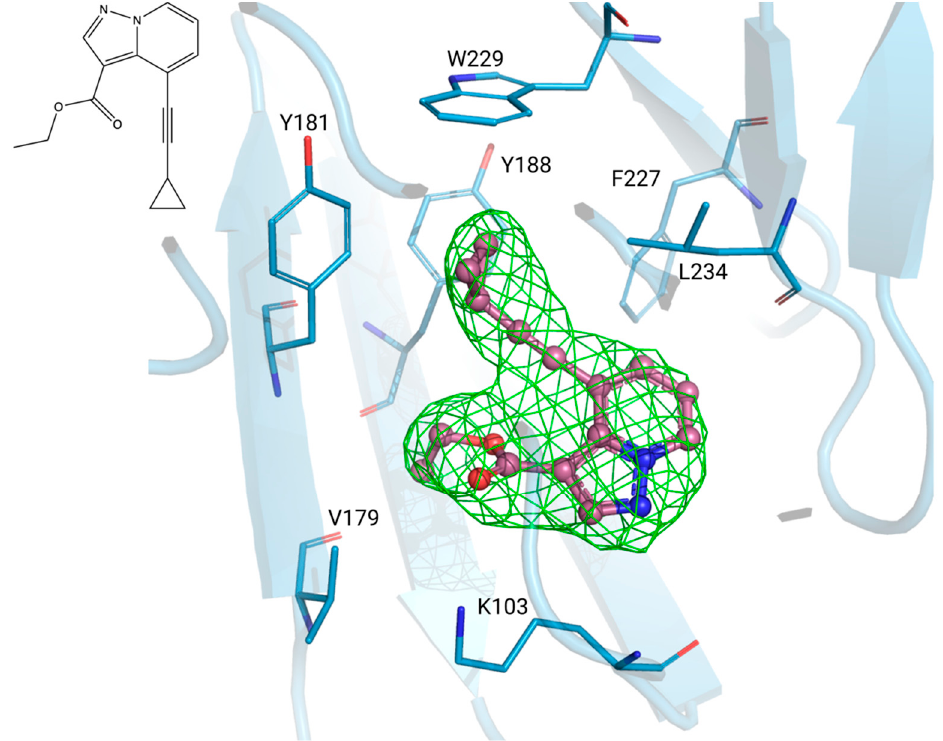
Figure 3. Crystal structure of HIV-1 RT in complex with the elaborated compound 27 (PDB ID 8FFX). Atomic model of 27 (magenta) bound to HIV-1 RT residues (blue) in the NNRTI-binding pocket. Pocket residues forming hydrophobic interactions shows as sticks. Polder mFo–DFc (OMIT) map density (green mesh, 3 σ ) of 27 . Created using PyMOL and BioRender.com.